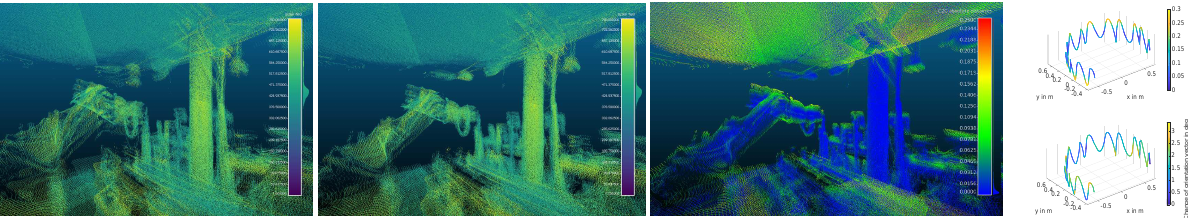
Figure 9. Sinusoid Distortion: Left: Input Point Cloud. Middle: Corrected point cloud. Right: Error between corrected and reference point cloud. Plots: Above: Point to point distance between the corrected and original trajectory. Below: Change of orientation vector between the corrected and original